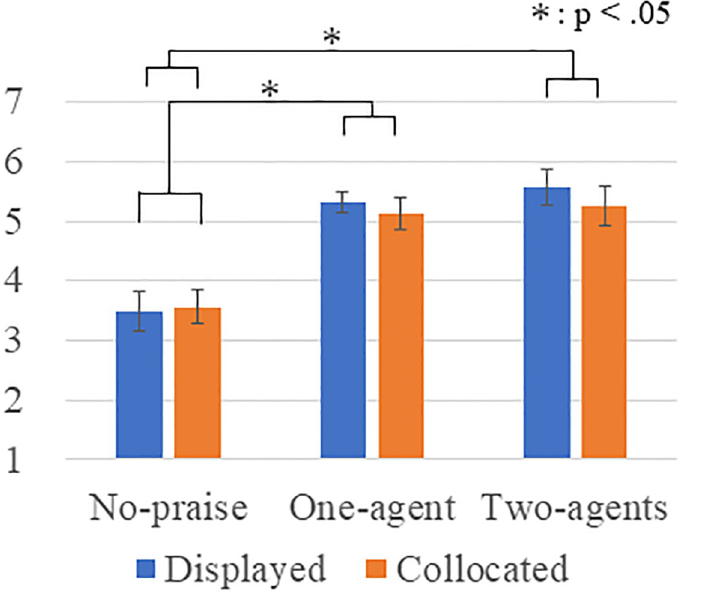
Fig 7. Happiness